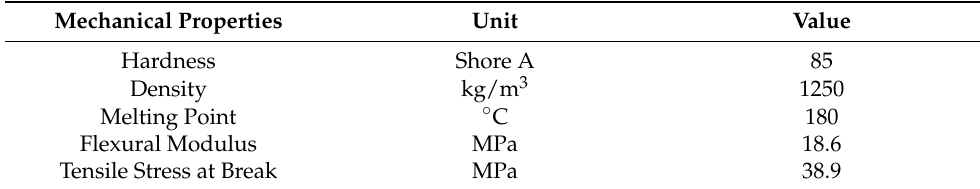
Table 1. Mechanical property of Tecoflex EG